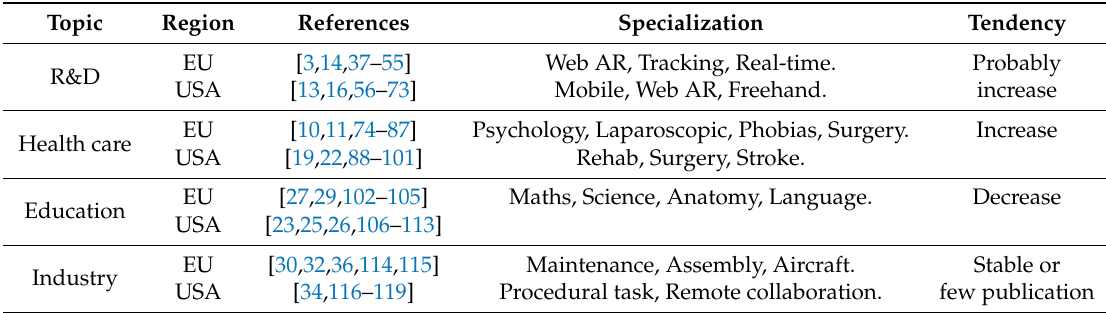
Table 3. Summary of publications by topics EU and